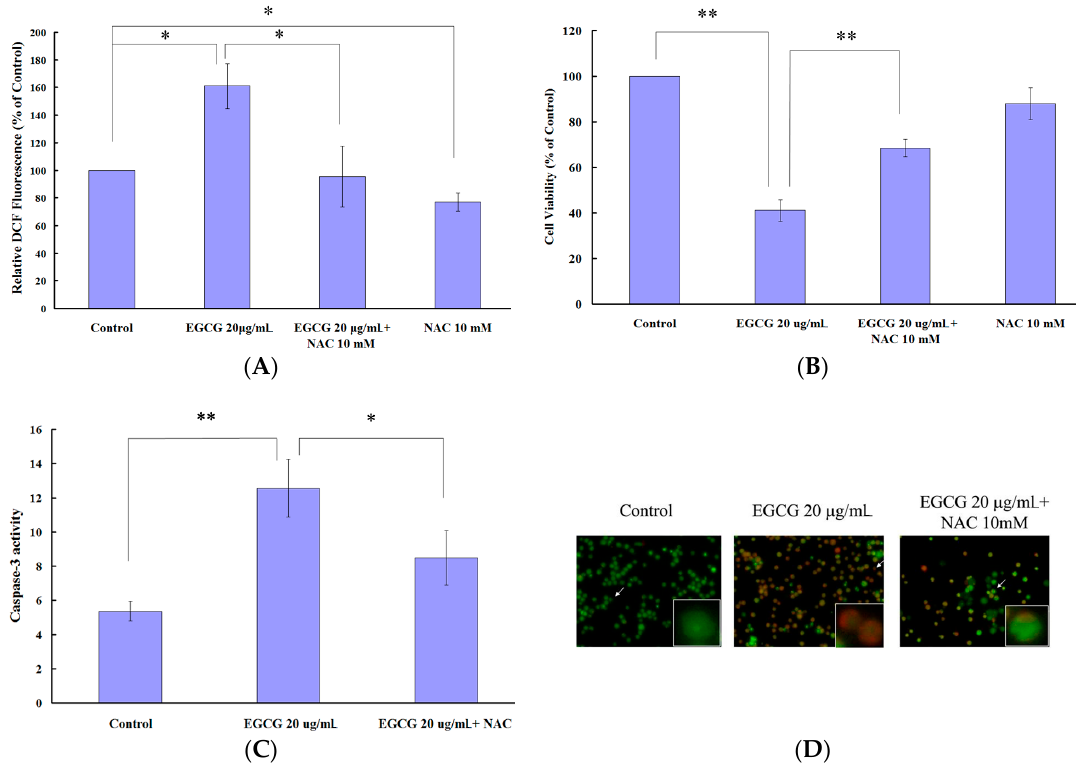
Figure 5. N -acetylcysteine attenuated the EGCG-induced ROS generation, cytotoxicity, caspase-3 activation, and formation of acidic vesicular organelles in PEL cells. PEL cells were preincubated with or without N -acetylcysteine (NAC) for 1 h before treatment with 20 μ g/mL EGCG for 24 h. ( A ) The ROS generation was detected by staining with H 2 DCFDA; ( B ) The cell viability was determined by trypan blue exclusion assay; ( C ) The caspase-3 activity assay was evaluated by using the CaspACE Assay System, Colorimetric (Promega); ( D ) The formation of acidic vesicular organelles (AVOs) was observed by acridine orange staining. The results are the means of three independent experiments, and bars represent the standard errors. The representative data are shown. * p < 0.05 and ** p < 0.01 indicates significant differences between the control and EGCG-treated cells.